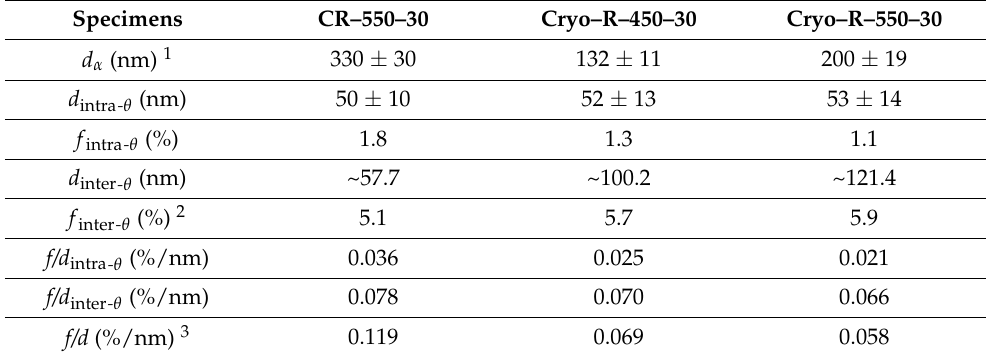
Table 1. Measured grain parameters of three